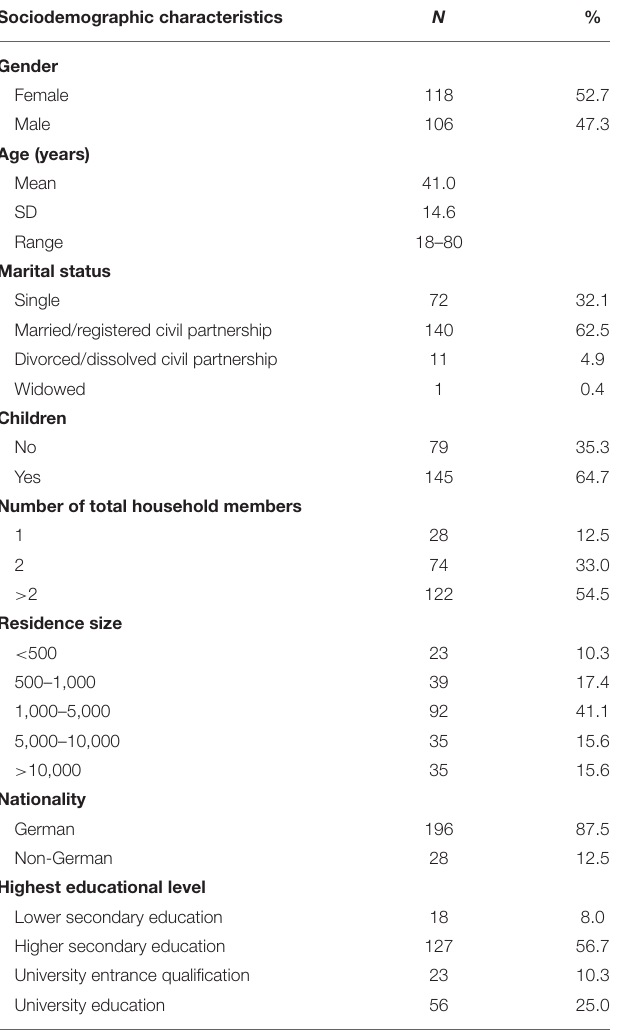
TABLE 1 | Study population characteristics: sociodemographic ( n = 224). Sociodemographic characteristics